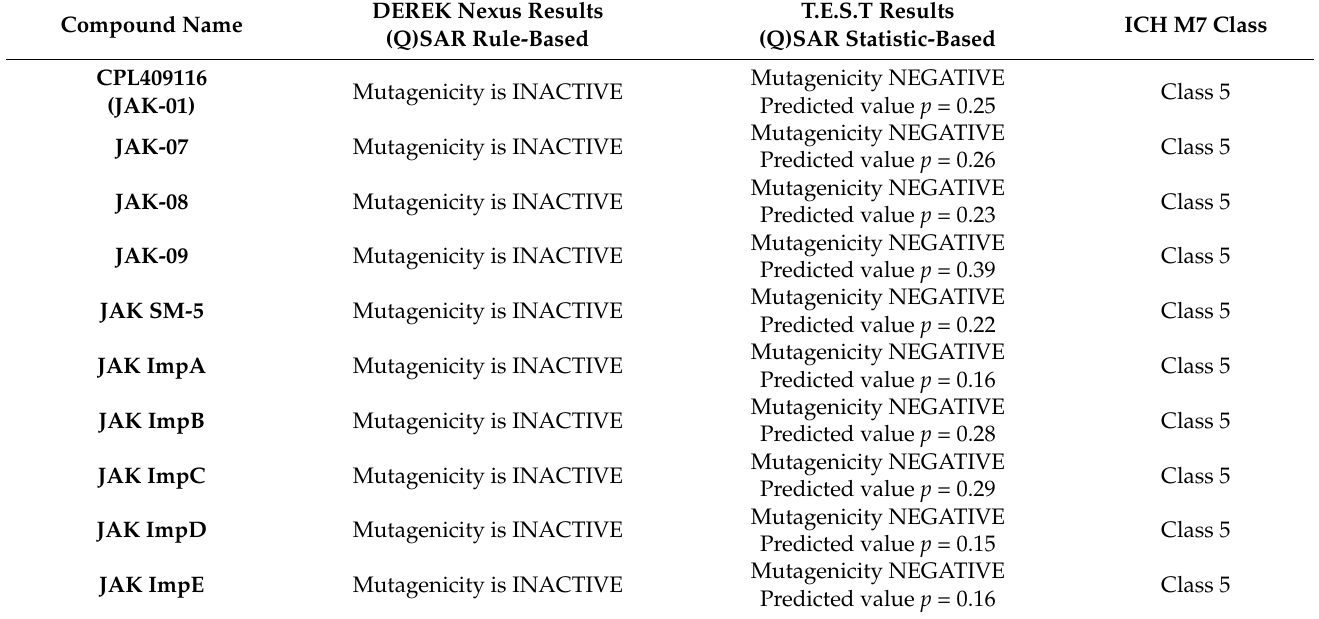
Table 3. Summary of evaluation of mutagenicity. (Q)SAR results for CPL409116 and related